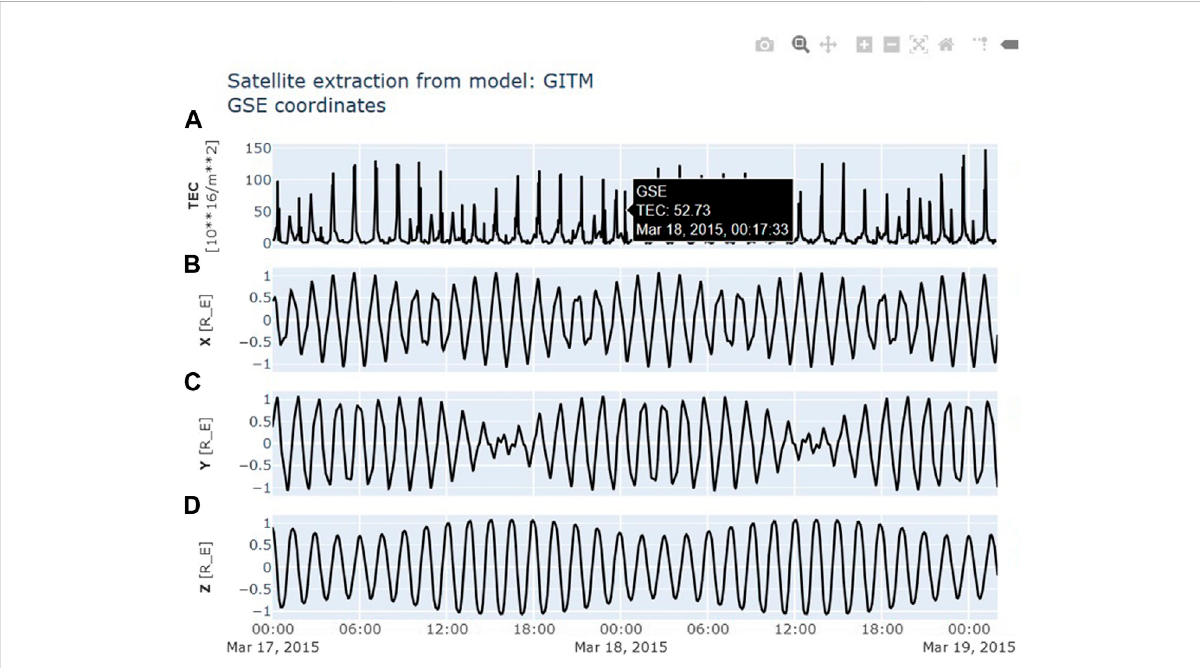
FIGURE 6 An example of afully interactive 1D plot. As inFigure 5, the total electron content (TEC) is plotted for the entirety of agiven satellite trajectoryat top (A) , followed bythe trajectory parameters inCartesian coordinatesin theremaining three plots (B – D) . The model source and coordinatesystem areprintedinthetopleftcorner.HoveringoveravalueinanyoftheplotsgivesaboxcontainingthevalueandthedateandtimeinUTC.Thesymbols on the top right are the typical buttons provided by Plotly. The plot is saved as a fully interactive html fi le. An example is included on the NASA Kamodo repository 5